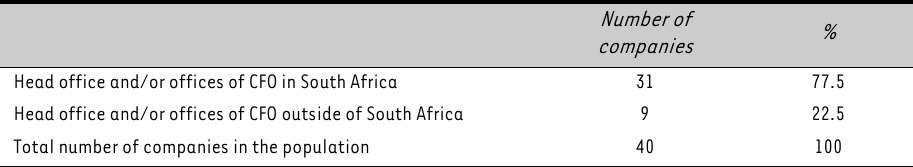
Location of head offices and/or offices of